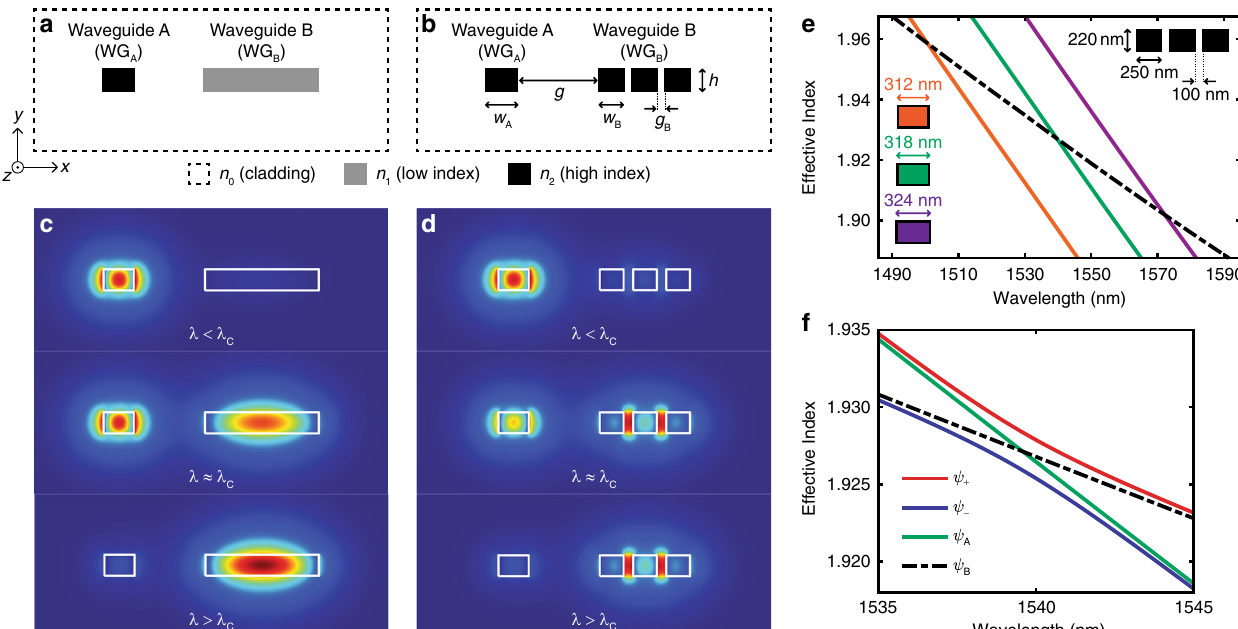
Fig. 1 Spectrally selective waveguide cross-sections and their eigenmode analyses. a Waveguide cross-section created by two waveguides made from different core materials ( n 0 < n 1 < n 2 ). Waveguide A (WG A ) is made from a higher index core than Waveguide B (WG B ) and is therefore narrower to satisfy the phase matching condition at the cutoff wavelength ( λ C ). b Equivalent waveguide cross-section created using a single material where WG B consists of closely spaced sub-wavelength core segments made from the same material as WG A . Fundamental transverse electric modes at wavelengths ( λ ) below, equal to, and above the cutoff λ C c for the cross-section in a and d for the cross-section in b . With increasing wavelength, both sets of mode pro fi les indicate the spatial shift of the fundamental mode from WG A to WG B . Owing to the design of the segmented WG B in b , majority of the electric fi eld is located between the segments, in the SiO 2 cladding. Eigenmodes plotted with n 0 = 1.45 for the SiO 2 cladding, n 1 ≈ 2.9 that can potentially be satis fi ed by a chalcogenide glass, and n 2 = 3.48 for Si within the C-band. e Effective indices of WG A (solid lines) and WG B (dashed line) from the cross-section in b . Layer height h = 220 nm for both waveguides. Intersection marks the cutoff wavelength for each w A . The shift of cutoff toward longer wavelengths depends on the width change as well as derivatives of the plotted effective indices. f Effective indices for the quasi-even ( ψ + ) and quasi-odd ( ψ − ) supermodes and the individual guided modes in WG A ( ψ A ) and WG B ( ψ B ). Indices are calculated for w A = 318 nm, and the same dimensions for WG B as in e . The quasi-even supermode follows the highest effective index available in the